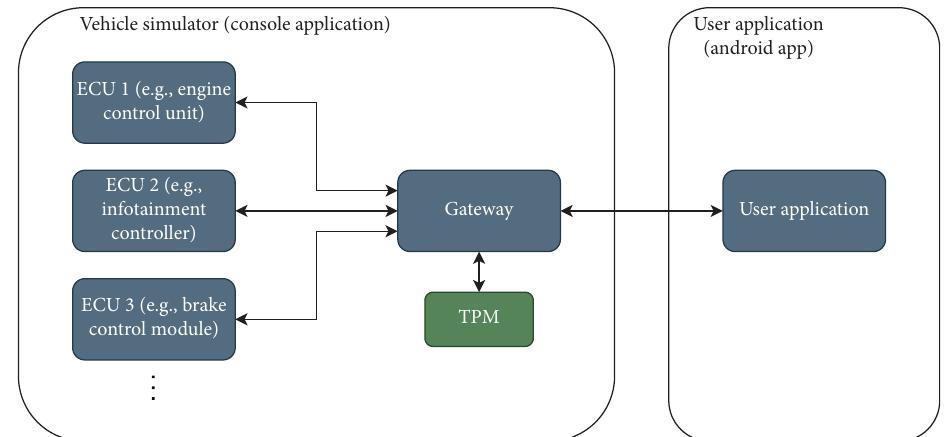
Figure 7: Model of the developed proof-of-concept prototype, consisting of the vehicle simulator with some ECUs and the central gateway and the user